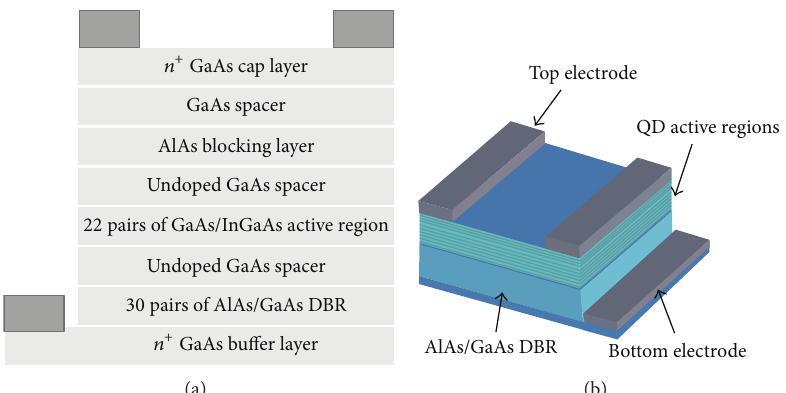
Figure 1: (a) The schematic diagram of the resonant-cavity-enhanced photodetector (RCE-PD). (b) The simplified 3D view of the device constructed.